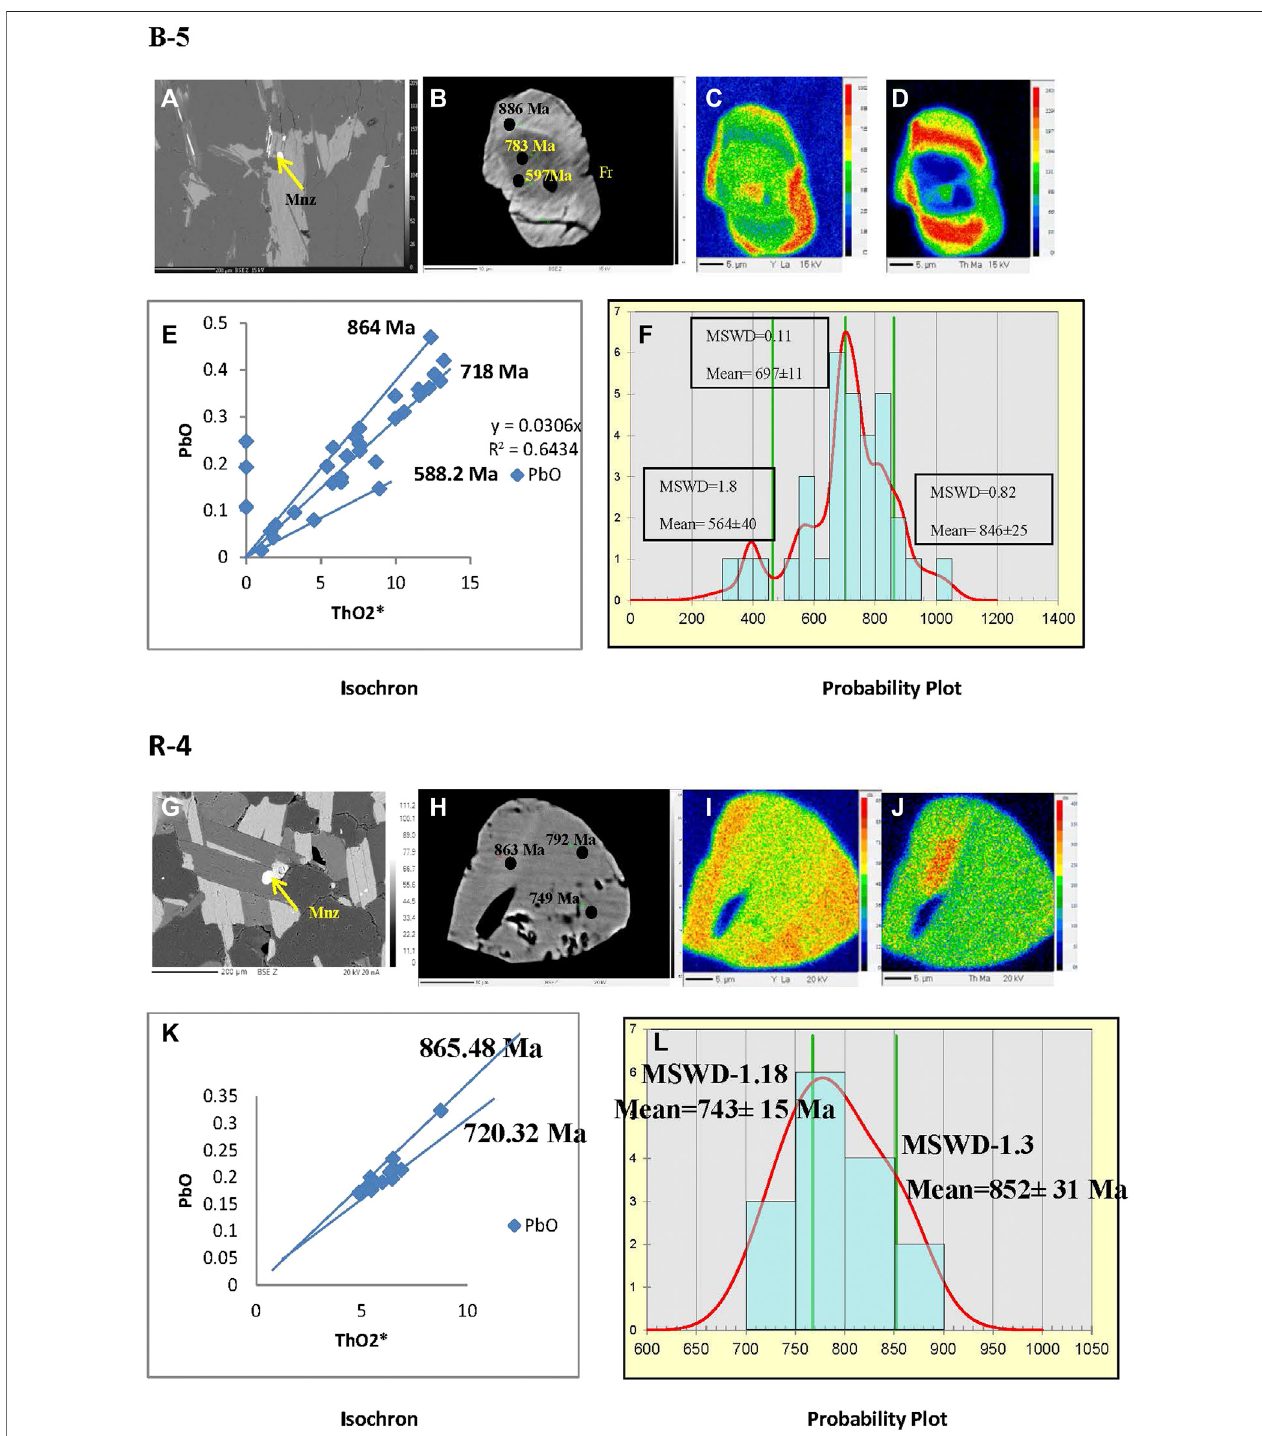
FIGURE9 | SampleB-5,collected from mica schist: (A) Monazite under BSE imageshows more or less equant shape and compositional domains. (B) The lighter domain that occursoutsideisYpoorand Thrich (X-ray images, (C) , (D)) yielding higher agesas886 Ma, indicatingtheageoftheD 1 .Thedarkerdomains, at thecenter, are Y rich and Th poor and yield 783 and 597 Ma ages, indicating D 2 and brittle deformation ages, respectively; there is minor fracture at the edge (Fr); fl uid migrated through the fracture and rejuvenated the age. (E and F) Isochronand probability curve yield three clusters as 864, 718, 588 Ma, 846, 697, 564 Ma corresponding toD 1 ,D 2 shearingandbrittleshearingages,respectively.SampleR-4.MicaschistnearPratapgarh,Monazitesarenearlyroundedtoequantshapeandhavedomains (G to J) . (K and L) Isochron and probability curve yield two distinct ages 865 – 720 Ma and 852 – 743 Ma corresponding to D 1 – D 2 ages, respectively.